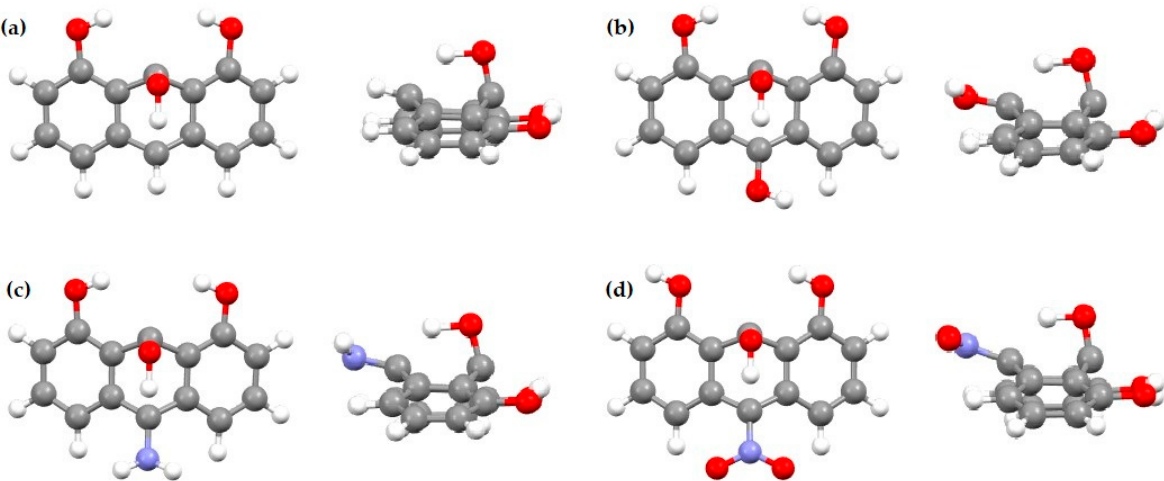
Figure 5. Transition state for 1,8-dihydroxy-9-anthrone without substituent—( a ), with OH substituent—( b ), with NH 2 —( c ), and with NO 2 —( d ).